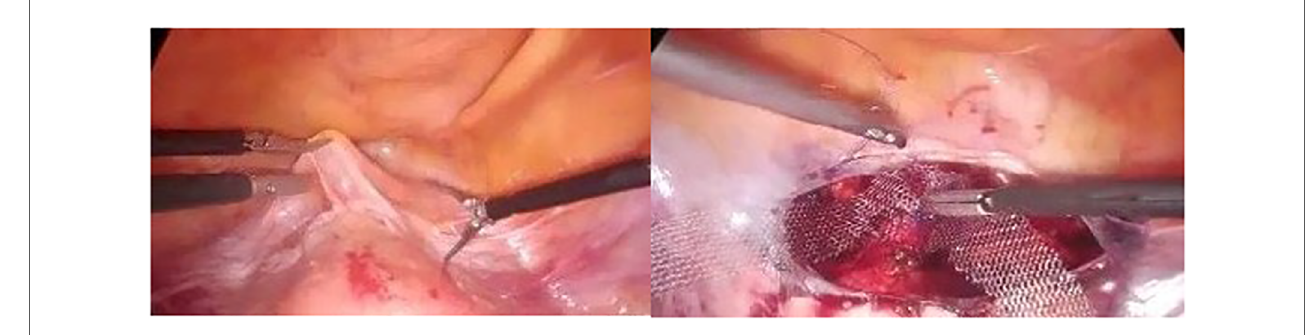
FIGURE 1 Opening the vesicouterine peritoneum and suturing the V-shaped mesh to the cervico-isthmic area.